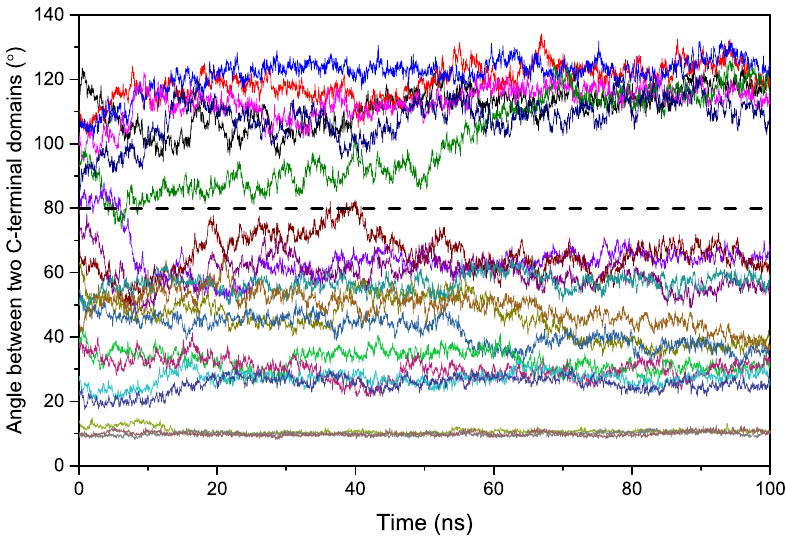
Figure 2. The angles between two C-terminal domains versus time for twenty systems